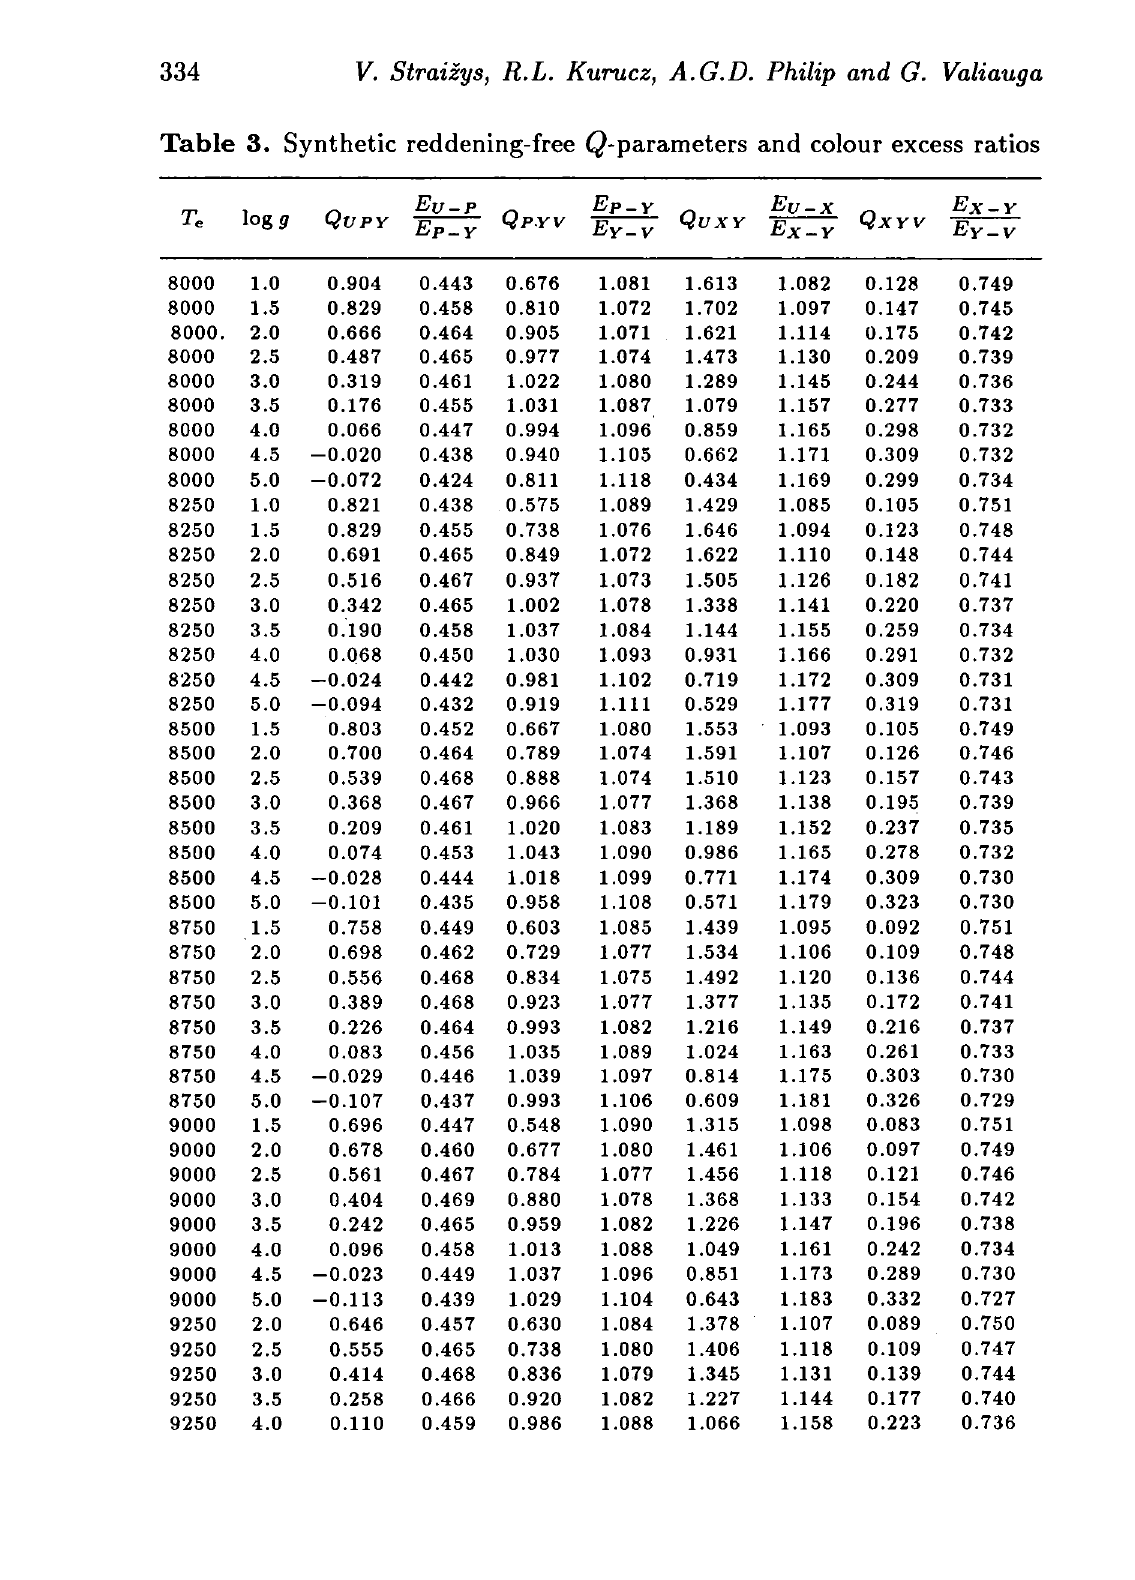
Table 3. Synthetic reddening-free Q-parameters and colour excess